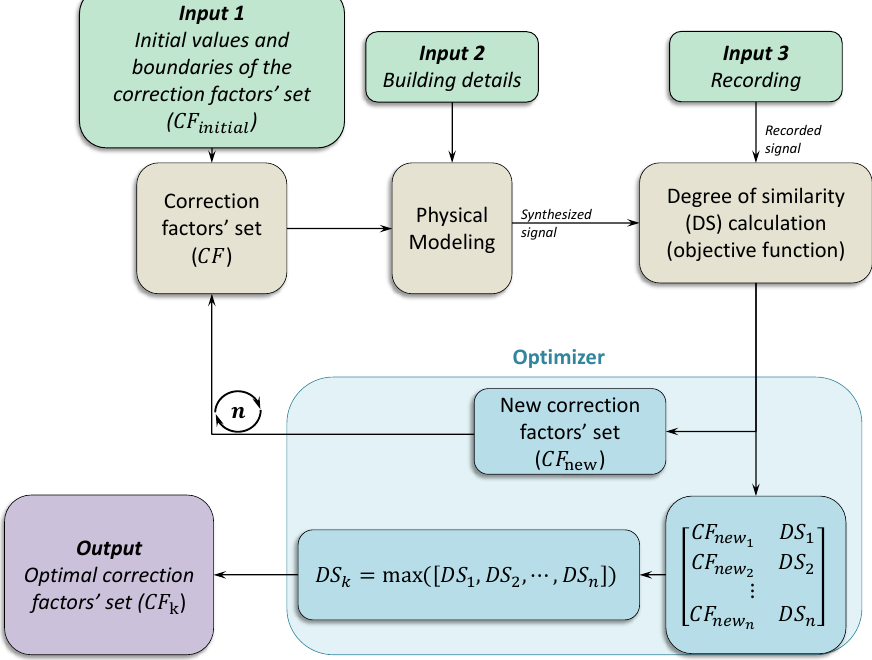
Figure 1. Block diagram of the Physical Modeling and Optimization framework integration, showing the input parameters and the looping procedure to output the optimal set of correction factors resulting in the maximum similarity between the synthesized and the recorded